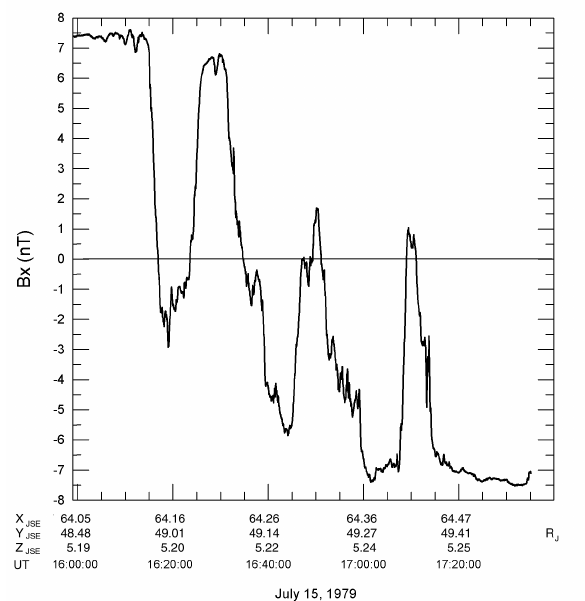
Fig. 2. B x -component during multiple crossing of the Jovian mag- netotail current sheet on 15 July 1979, at